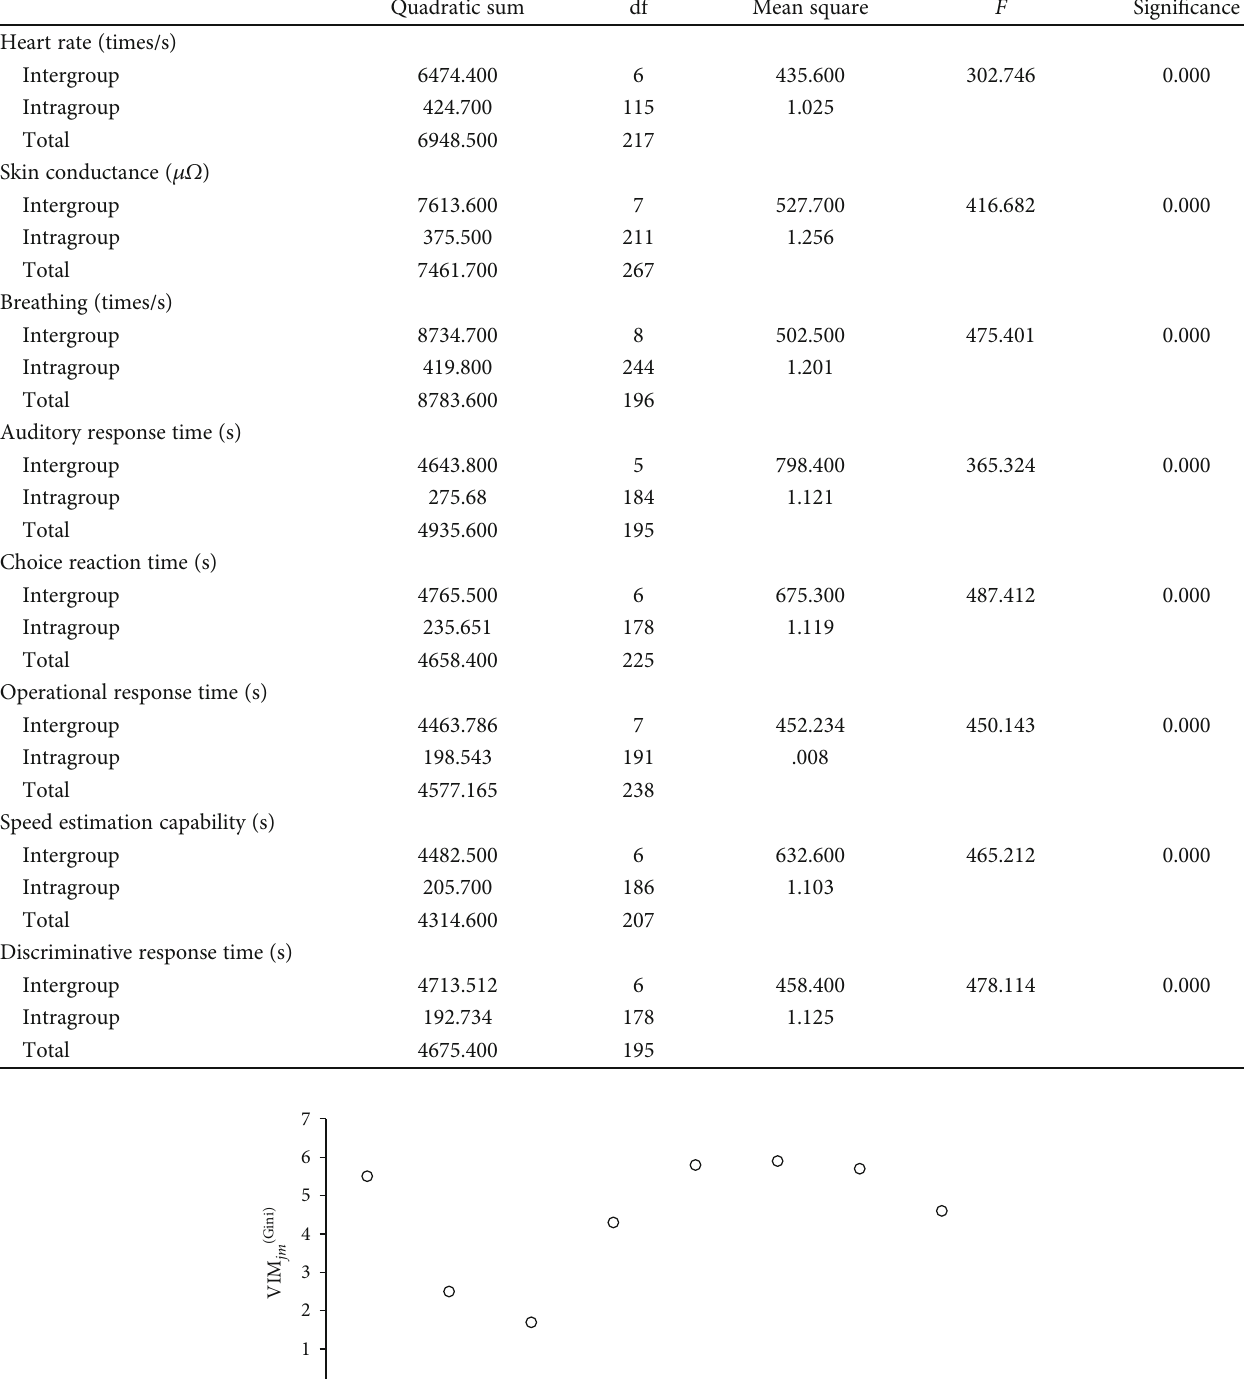
Table 5: Results of one-way ANOVA of pilots ’ physiological characteristics.